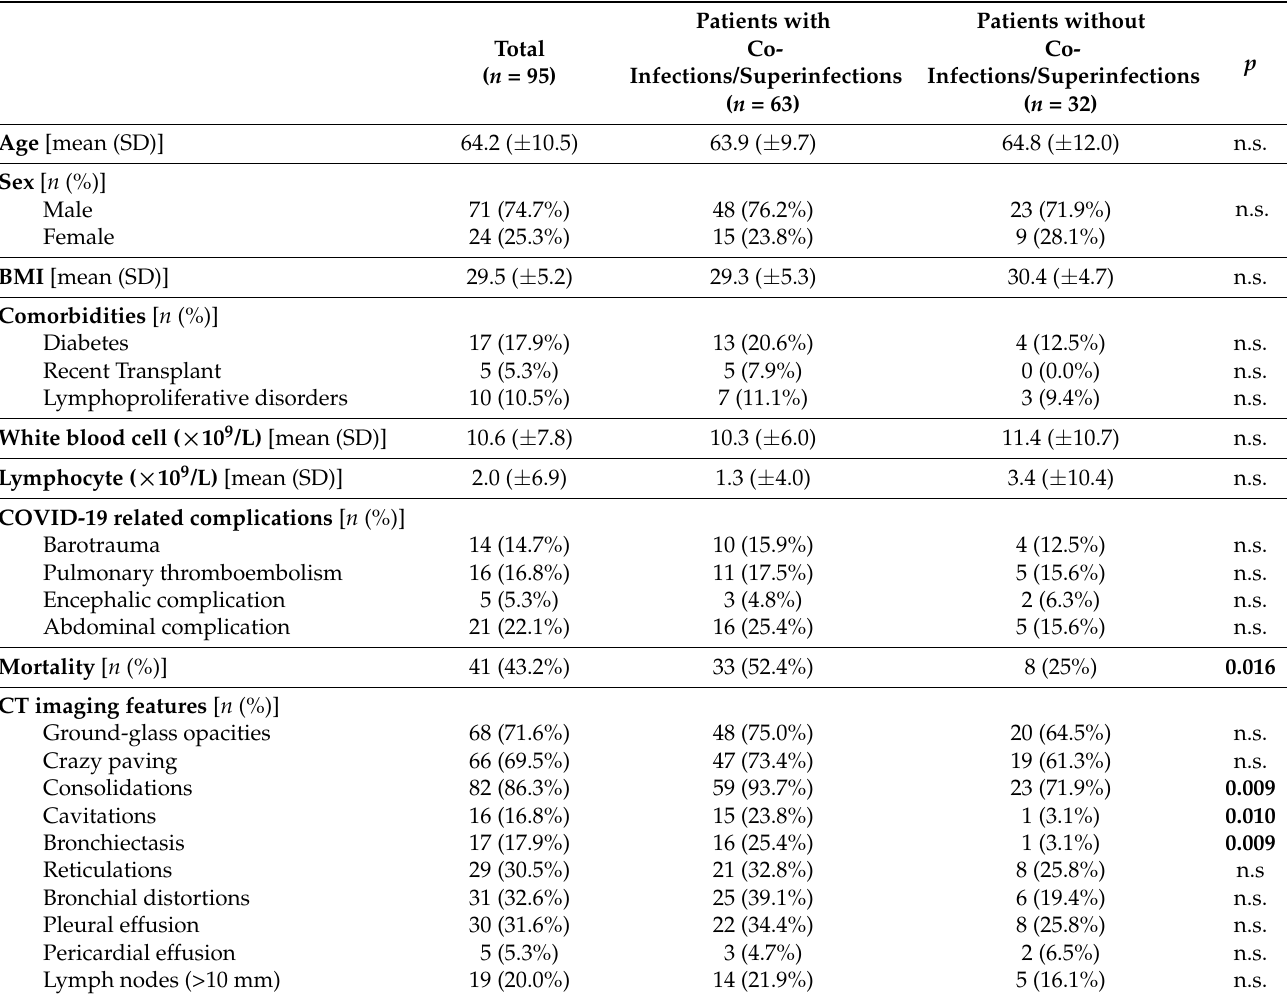
Table 1. Demographic, clinical, and radiological characteristics of the study population and compari- son between patients with and without co-infections/superinfections. Patients with Total ( n = 95)